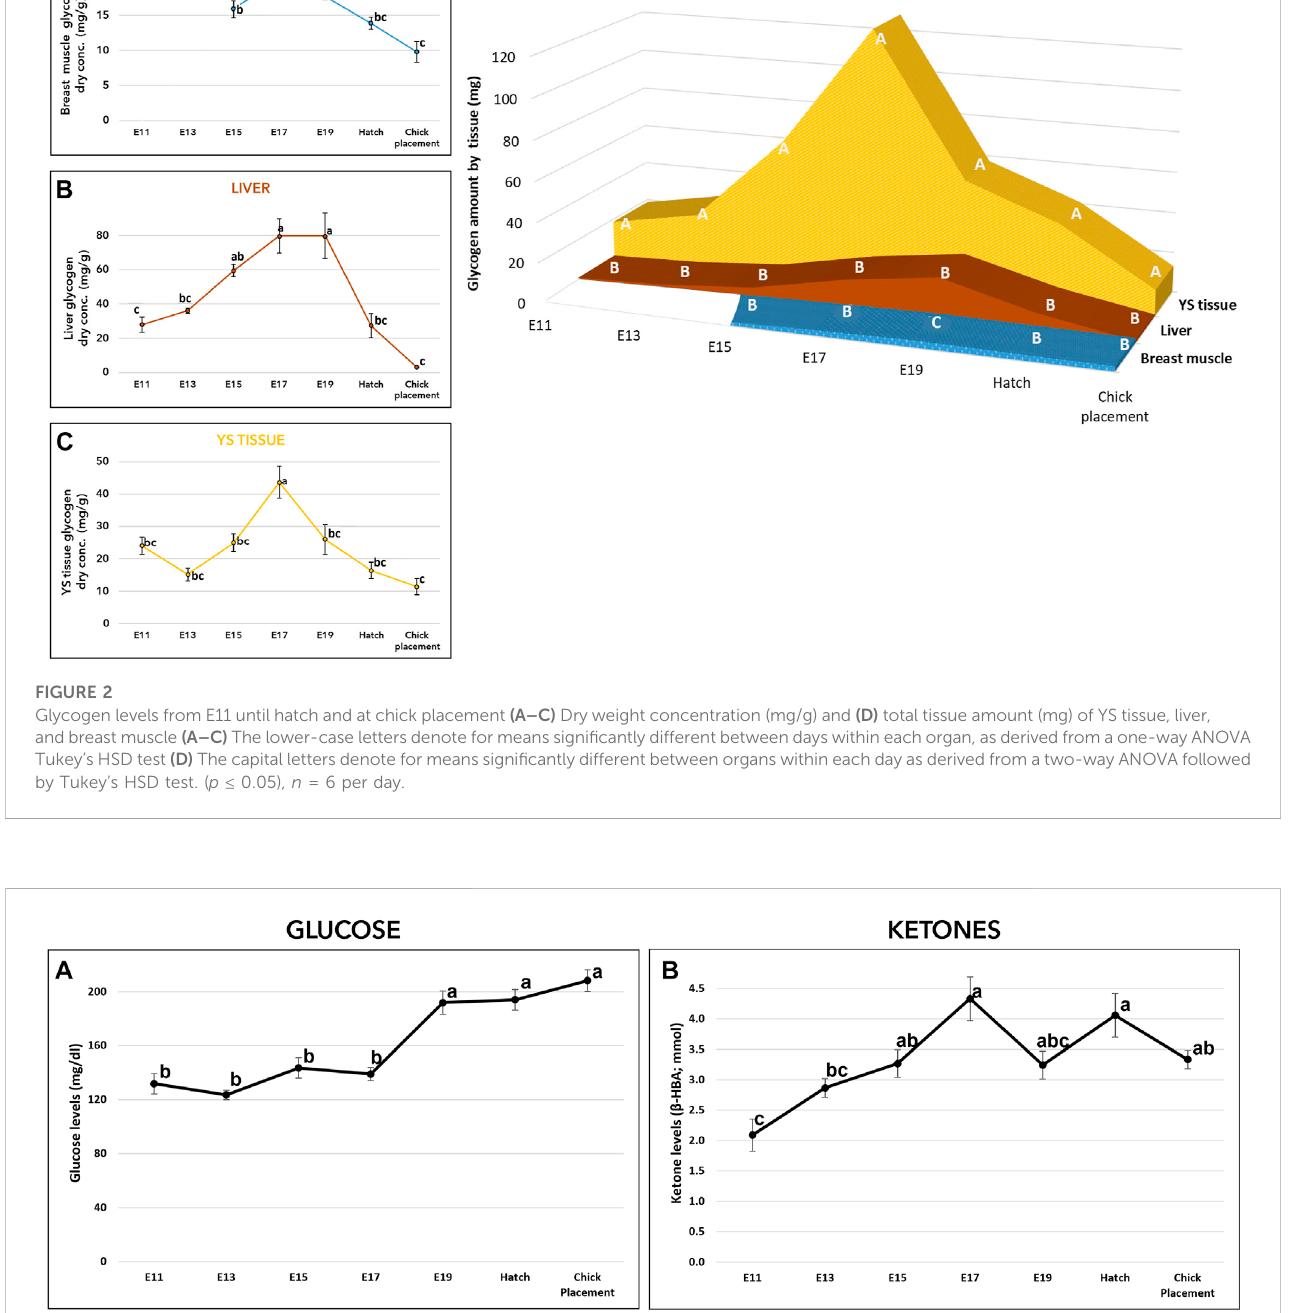
interaction was mainly associated with the varying expression patterns in tissues. In the breast muscle, AGAT expression showed a dynamic pattern, as it was increased from E11 to E19, followed by a decrease at hatch, then, sharply increased again reaching the highest level at chick